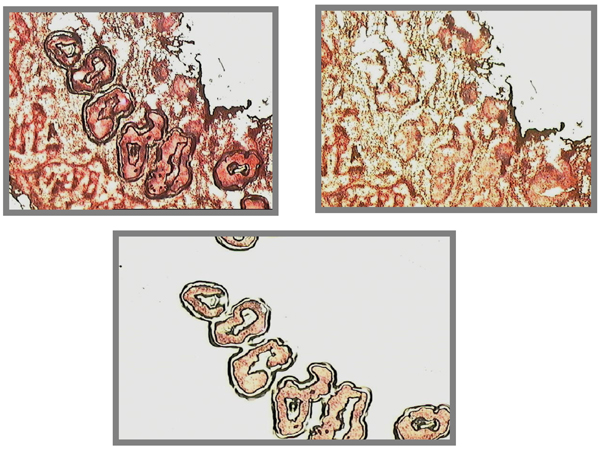
Laser capture microdissection of rhesus monkey endometrial glands [67]. Top left panel shows the laser etching of glands, top right panel shows the glands removed by the capture film, and the bottom panel shows the glands captured on the film.